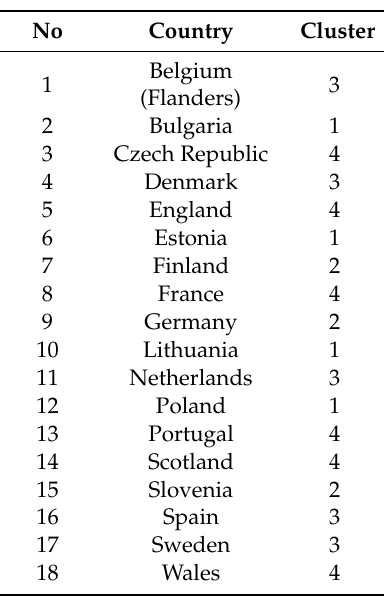
Table 11. Cluster analysis